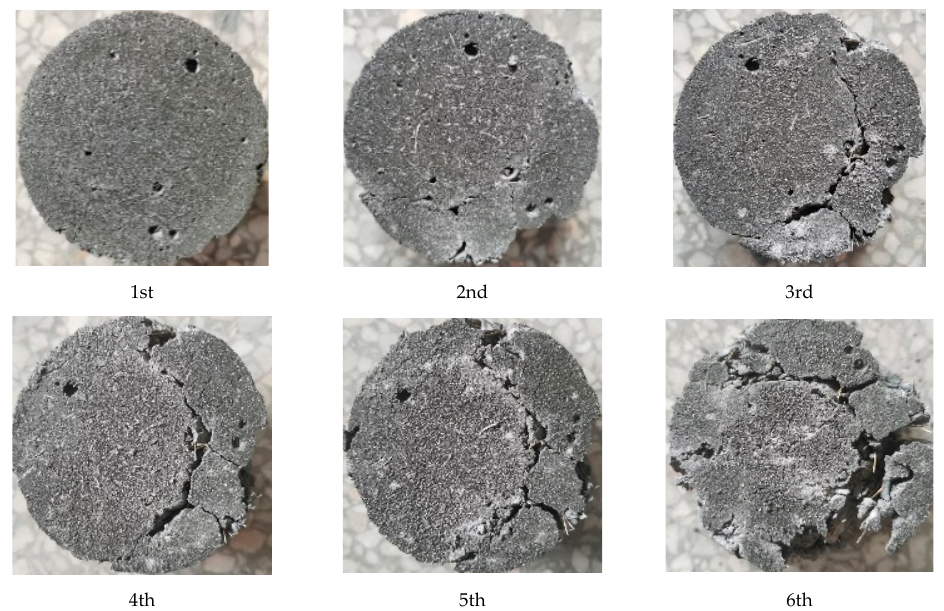
Figure 12. Failure pattern of fiber non-oriented multiple-impact compression specimens.